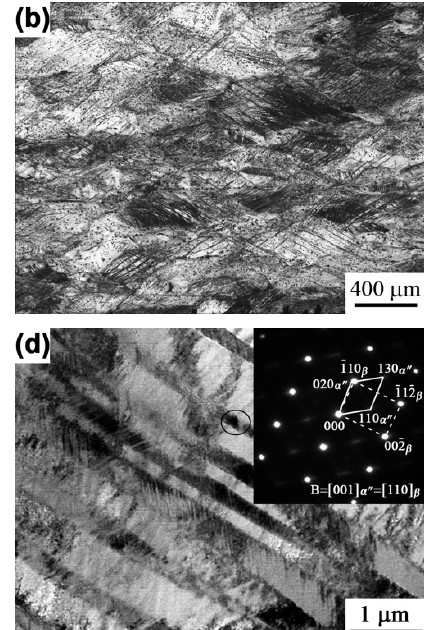
Figure 1. OM and TEM observation of the original specimen ( a , c ) and of the 40% rolled specimen ( b , d ).